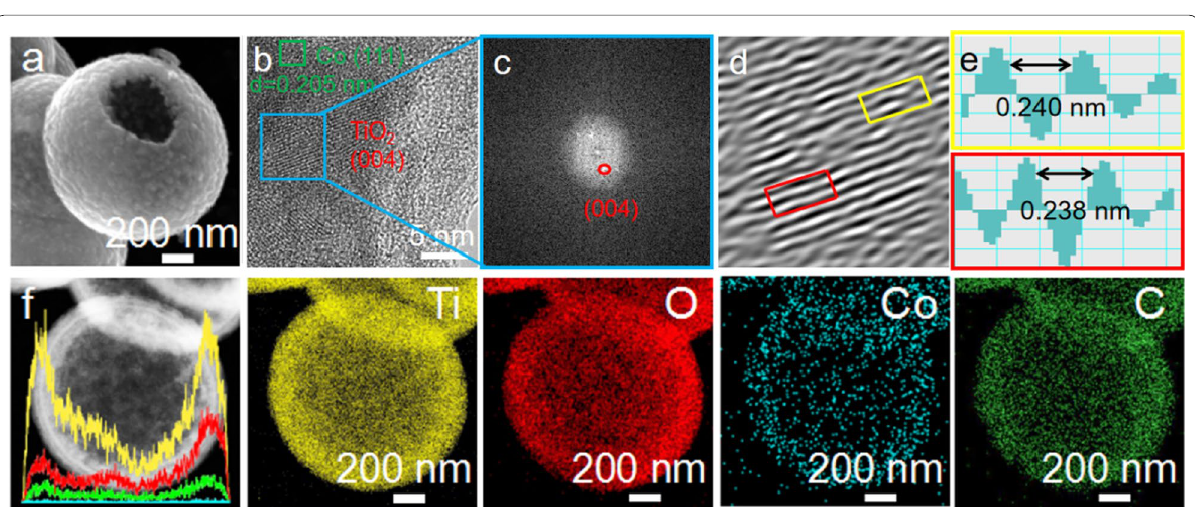
Fig. 4 a SEM; b high-resolution TEM image; c FFT pattern; d the inverse FFT crystalline lattice image; e the lattice spacing profiles at selected areas in yellow and red; f linear scan and corresponding elemental mappings of Co@TiO 2